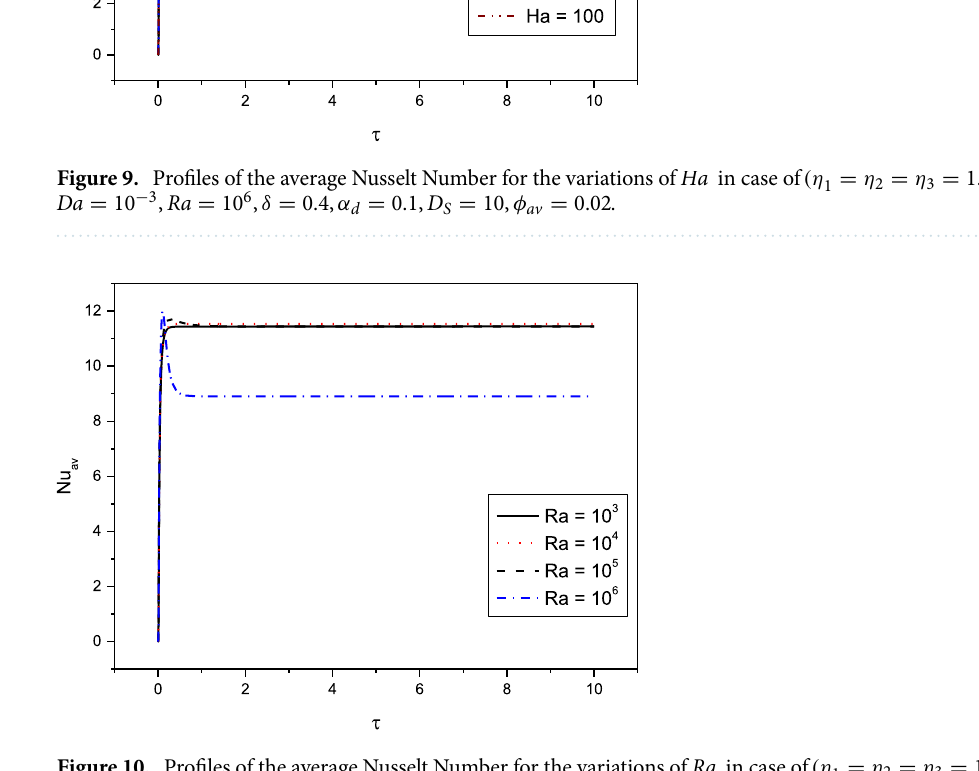
10, D 10, φ 0.02 S = av = =